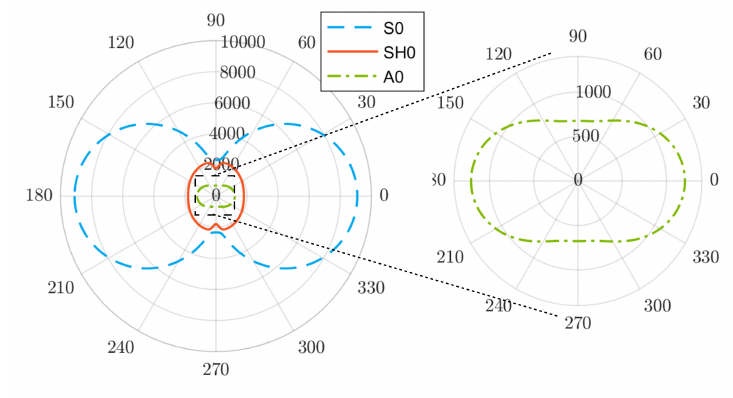
Figure 4. Angular profile of the phase velocity c ph at 50kHz for the simulated plate (T300/924C).